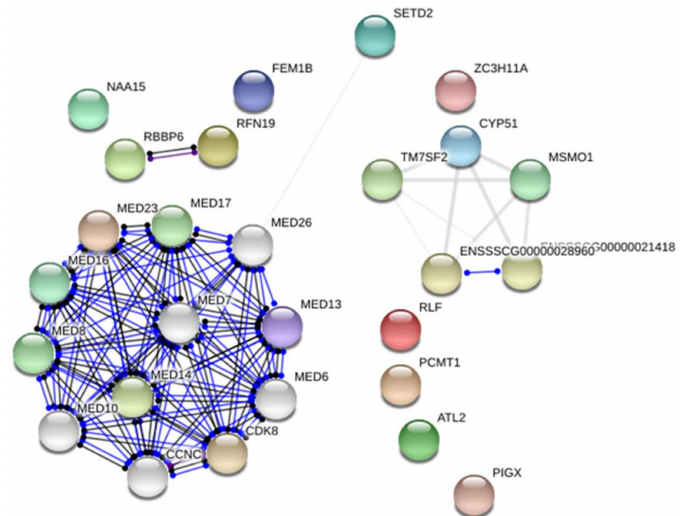
Figure 2. The differentially expressed genes were down-regulated in muscles of pigs with higher muscle mass. Detected genes were coloured and showed no more than 20 interactions (genes marked in grey); line shape indicates the predicted mode of action. Lines coloured indicate the predicted mode of action (blue—interactions from curated databases; black—co-expression). Network were presented as a scalable vector graphic and based on Sus scrofa